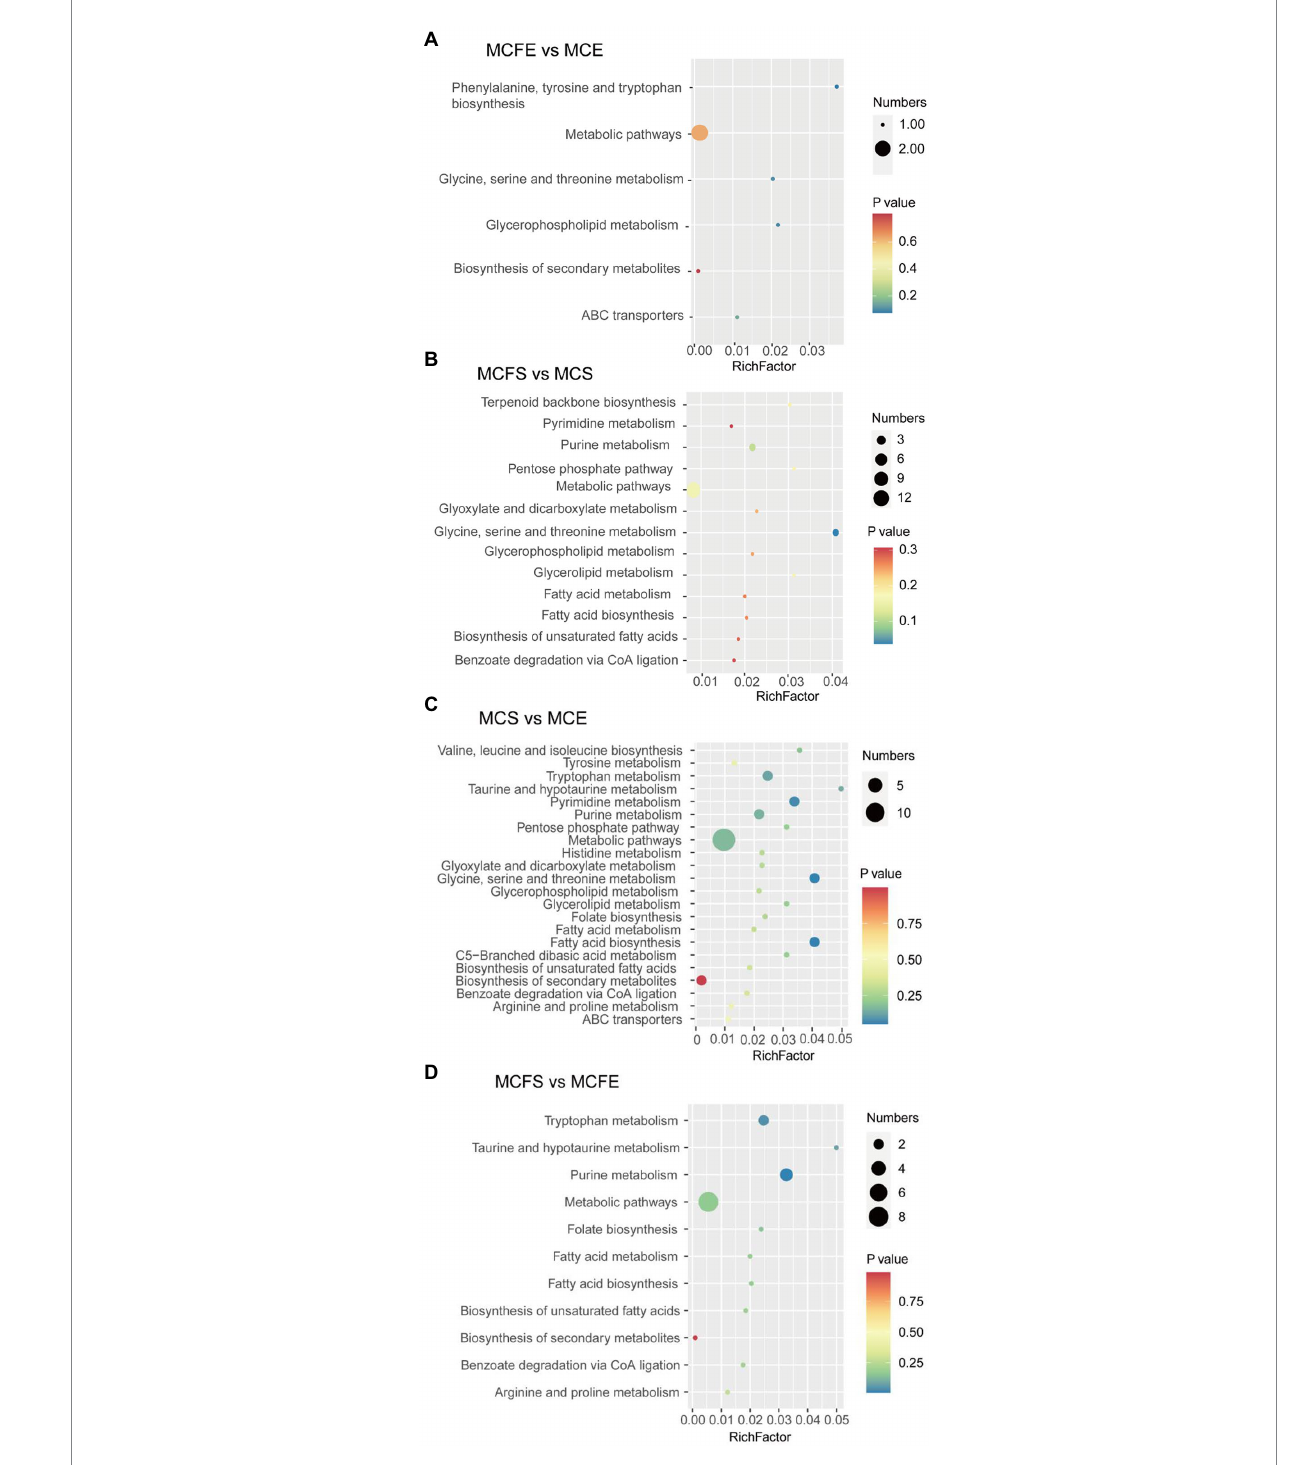
FIGURE 6 Bubble diagram of KEGG pathway annotation covered by differential metabolites. The x-axis indicates the scale of the “Rich factor” (the ratio of the number of differential metabolites in the corresponding pathway to the total metabolites annotated by the pathway detection), while the y-axis presents individual pathways identified. The color of the bubble indicates the p value of enrichment analysis with darker colors having a lower value and more significant enrichment. Size of the bubble is proportional to the number of metabolites in this pathway. Bubble diagrams of MCFE vs. MCE (A) ; MCFS vs. MCS (B) ; MCS vs. MCE (C) ; MCFS vs. MCFE (D) . MCE, MC-producing strain at exponential phase; MCFE, MC-free strain at exponential phase; MCS, MC-producing strain at stationary phase; MCFS, MC-free strain at stationary